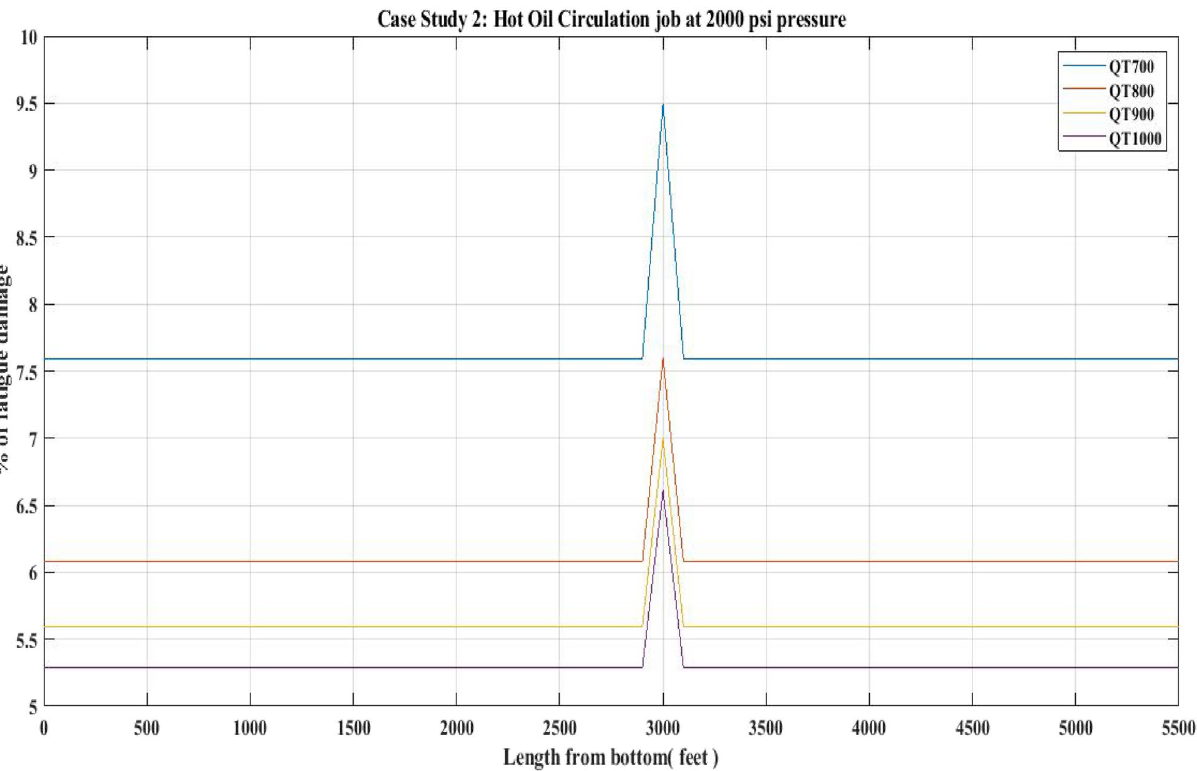
Figure 26. Percentage of fatigue damage with respect to hot oil circulation at 2000 psi pressure.